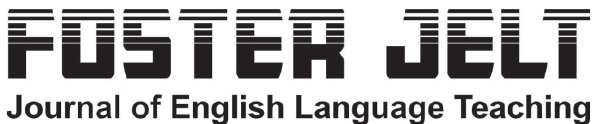
Table 5. Open-ended questions in the production stage Wh- question Instruction